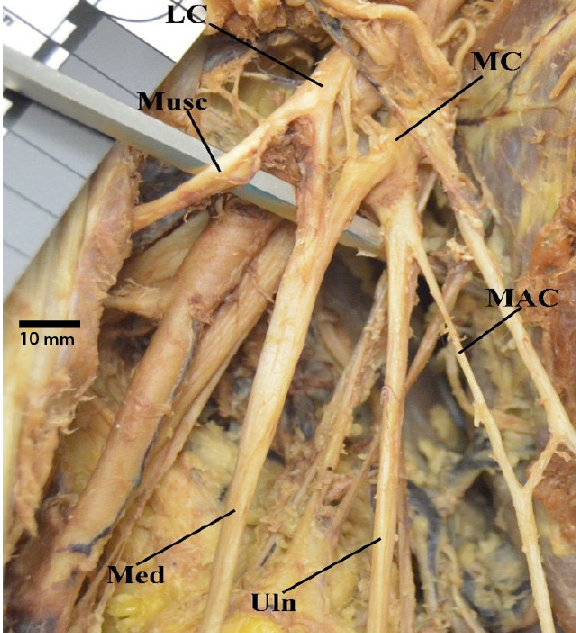
Figure 8. Photograph demonstrating a medial antebrachial cutaneous nerve arising from the ulnar nerve. Abbreviations: LC = lateral cord; MAC = medial antebrachial cutaneous nerve; MC = medial cord; Med = median nerve; Musc = musculocutaneous nerve; Uln = ulnar nerve.